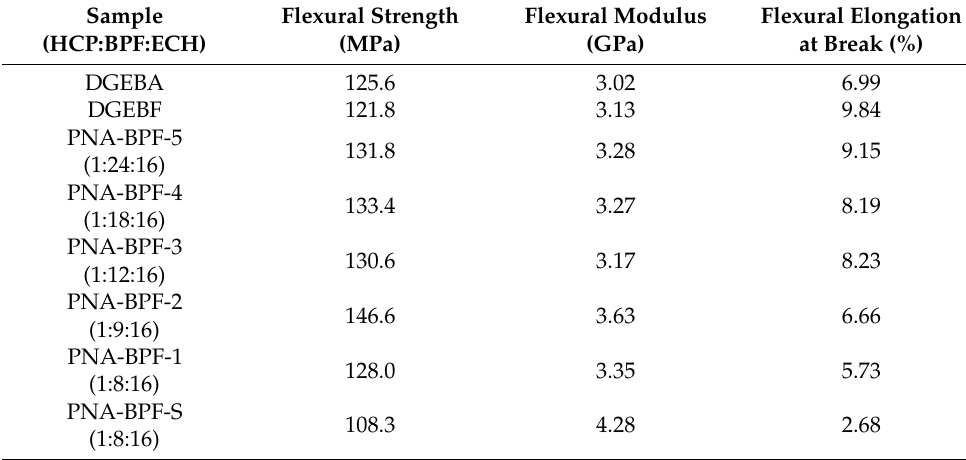
Table 8. Flexural properties of the cured epoxy resins compared to base epoxy